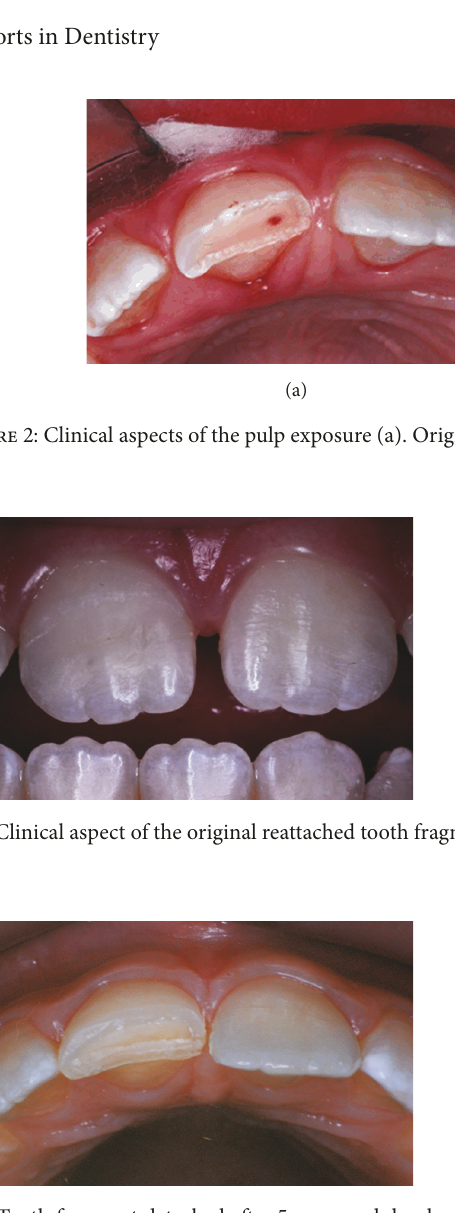
Figure 4: Tooth fragment detached after 5 years and development of the dentin barrier.